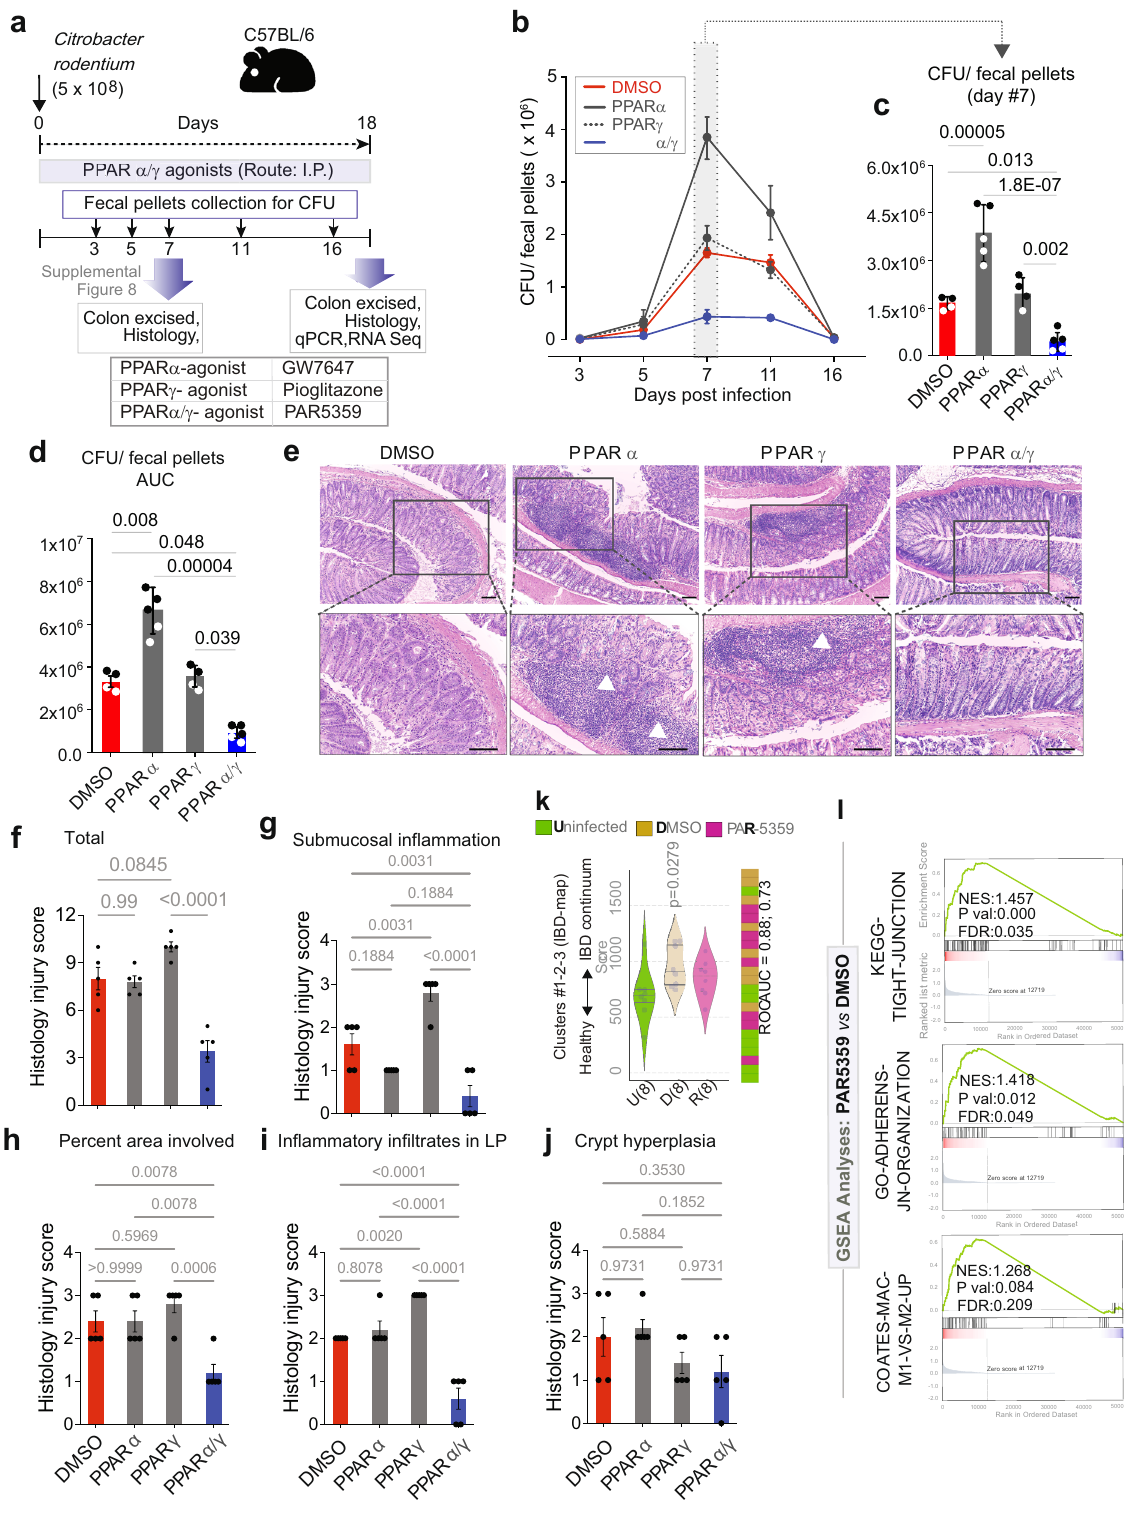
Supplemental Figure